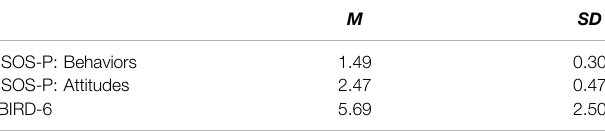
TABLE 3 | Mean and standard deviation for self-reported